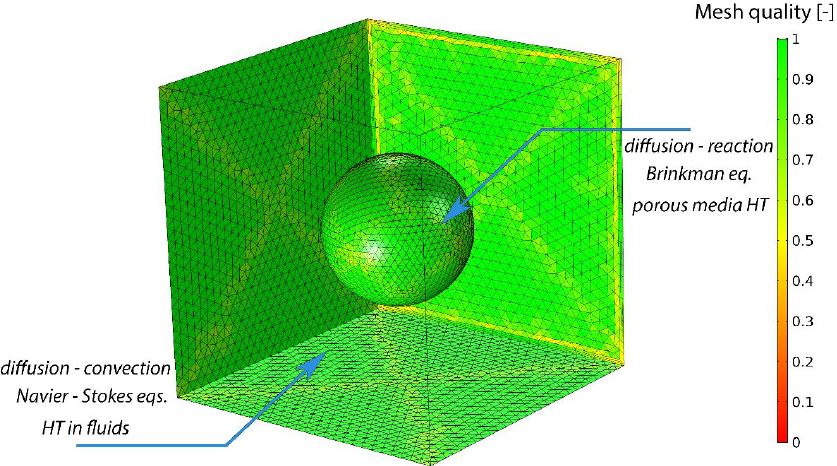
Figure 3. Particle model geometry, phenomena considered, and mesh quality in terms of element skewness (1 was highest quality).